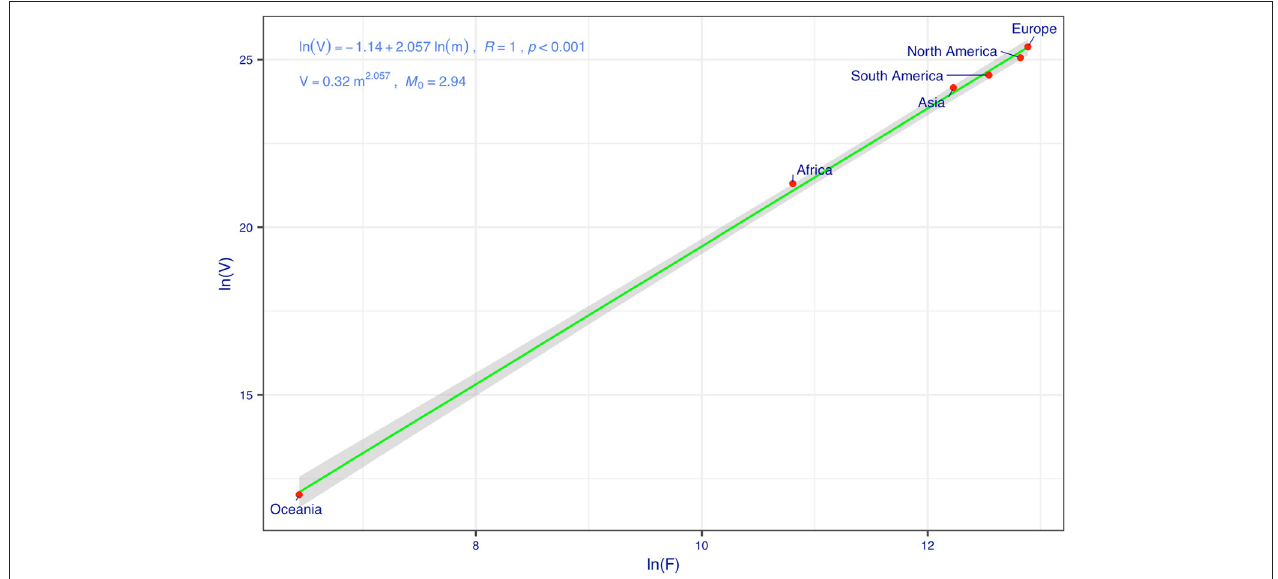
FIGURE 2 | Taylor’s power law (TPL) model for the cumulative counts of COVID-19 fatalities: the variance corresponding to the mean fatality (F) is used to compute the SE and width of